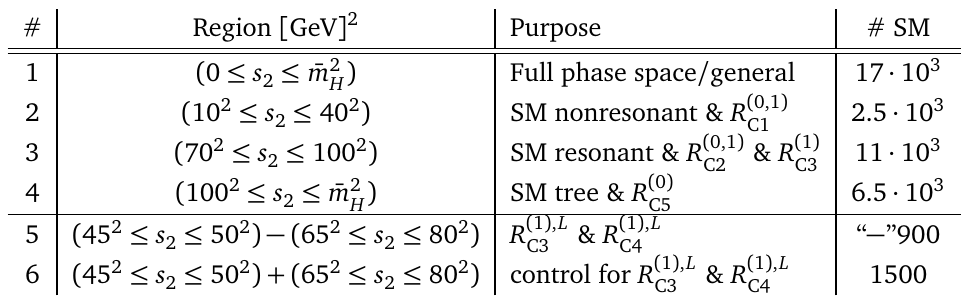
Table 3: Regions in s chosen to emphasize various SMEFT effects. All regions should 2 be understood to be limited to the physical phase space region, for example ¯ m 2 may H be outside the physical region and instead s is integrated to the maximum value. 2 The combined regions 5 and 6 are understood as the sum or difference between the integrated regions in s . s is always integrated from the lowest to highest physical 2 1 values. The first four regions approximately correspond to those proposed in [ 8 ] . The column labeled “# SM” is the approximate number of SM decays H → µµγ expected at HL-LHC with 3 / ab integrated luminosity. The negative sign for the number of events in region 5 simply indicates that more decays occur in one region of the phase space than the other and we are taking the